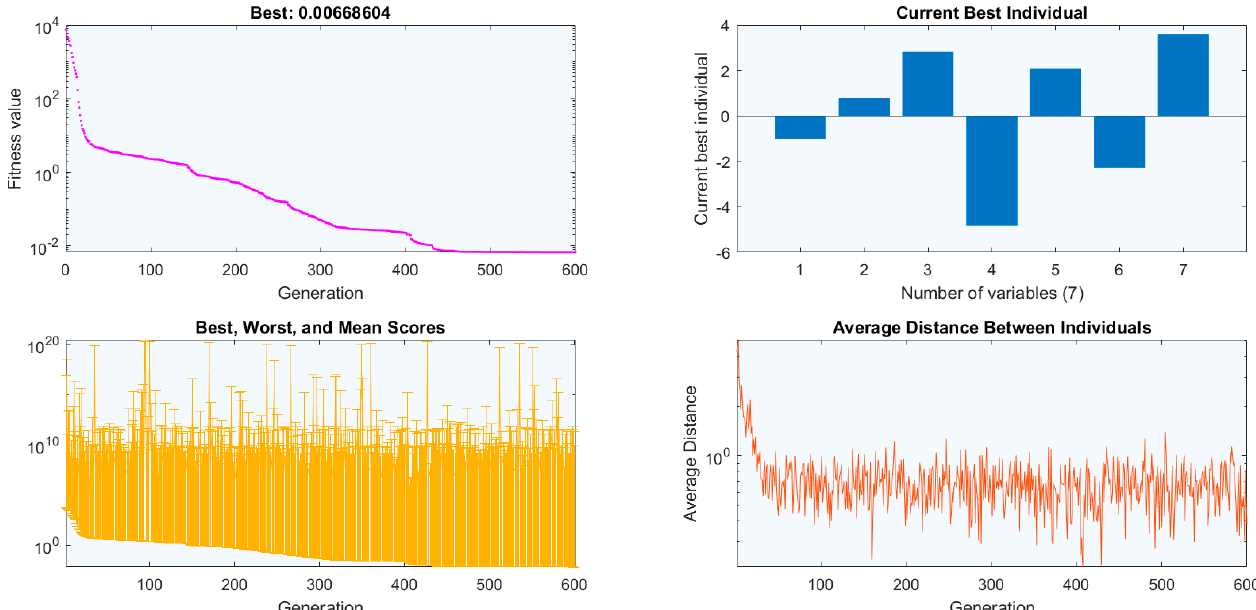
Figure 11. Results of Problem 2 in terms of learning curve, best individual scores, and average distance for 0.001 noise level.